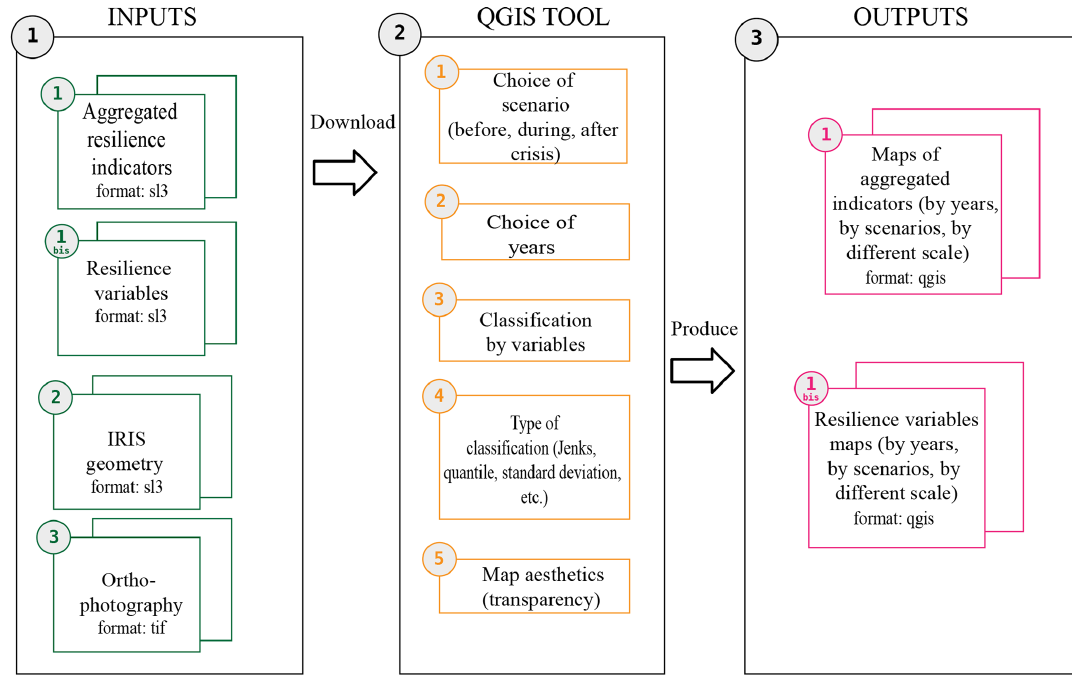
Figure 8. QGIS interaction architecture for resilience